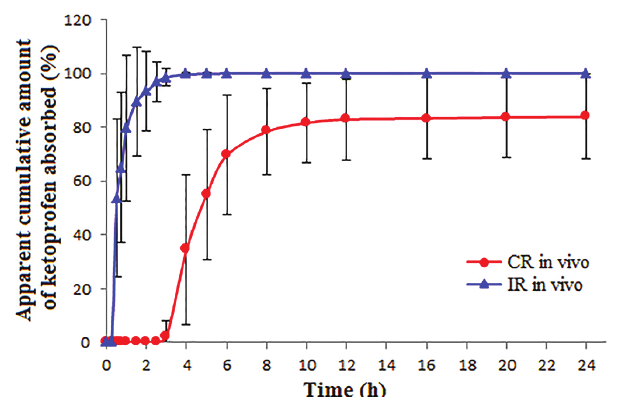
FIGURE 4 – Apparent cumulative amount of ketoprofen absorbed following the administration of IR-tablets and CR- tablets (n=6). IR-tablets – mini-tablets with immediate release; CR-tablets – compression-coated tablets for colonic